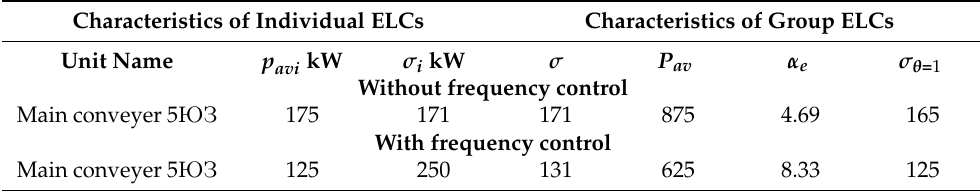
Table 11. Calculation formulae for the probabilistic characteristics of individual and group ELCs.